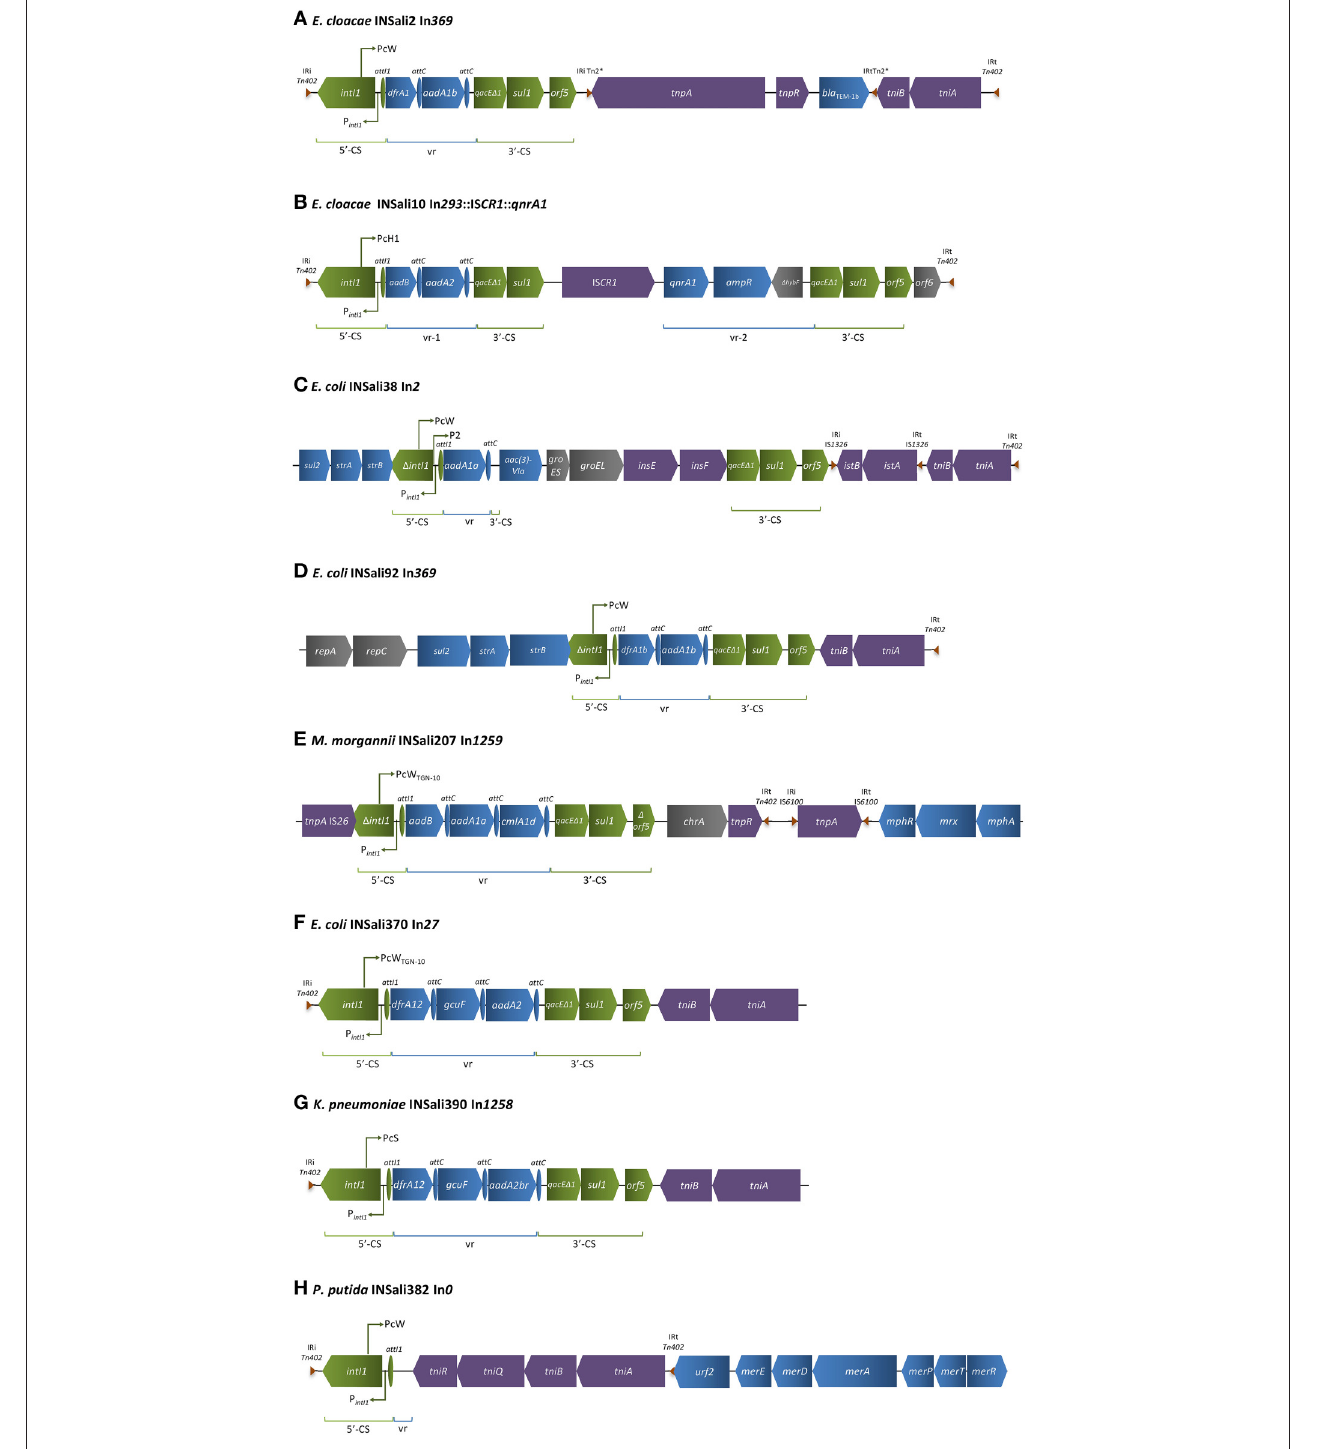
FIGURE 2 | Schematic representation of regions enclosing class 1 integrons detected among the bacterial population analyzed in the present survey ( n = 8/333). (A) E cloacae INSali2 In369; (B) E. cloacae INSali10 In 293 ::IS CR1 :: qnrA1; (C) E. coli INSali38 In 2; (D) E. coli INSali92 In 369; (E) M. morgannii INSali207 In 1259; (F) E. coli INSali370 In 27 ; (G) K. pneumoniae INSali390 In 1258 ; (H) P. putida INSali382 In 0. Green, integron; blue, resistance genes, including gene cassettes; purple, transposons; gray, other genes.